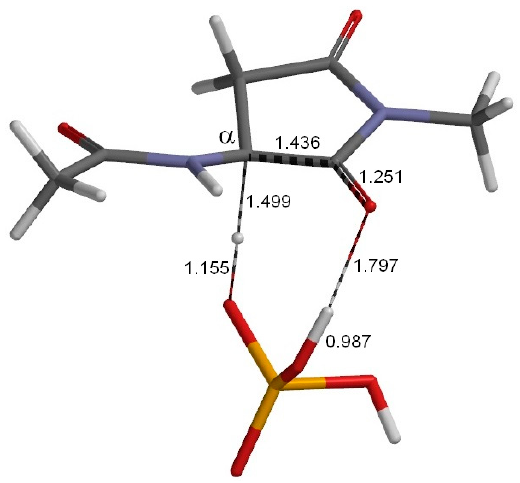
Figure 4. The geometry of the first transition state TS1 ( ϕ = 178 ◦ , ψ = − 150 ◦ , χ 1 = 146 ◦ ). This transition state is for enolization and connects RC (Figure 3) and EN1 (Figure 5). Selected interatomic distances are shown in Å. The imaginary frequency of this transition state is 856i cm − 1 . Grey: carbon; white: hydrogen; blue: nitrogen; red: oxygen; orange: phosphorus.